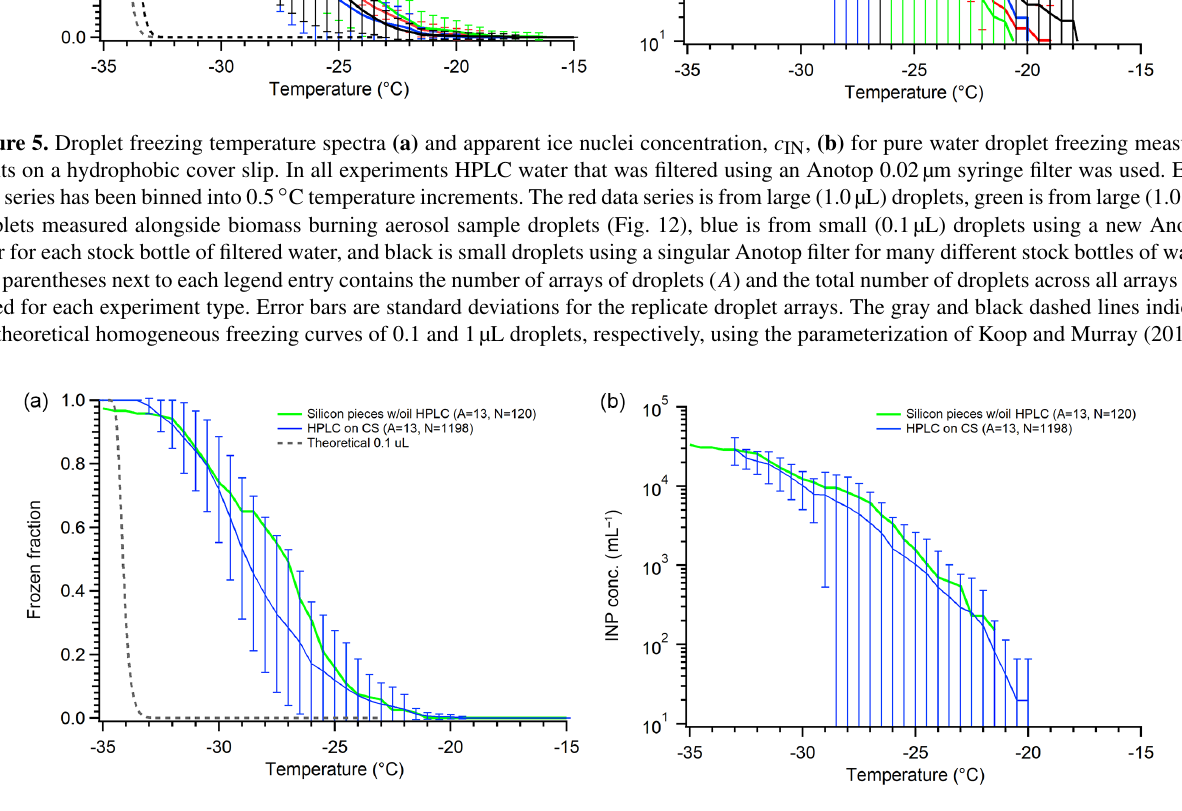
Figure 6. Comparison of freezing on silicon wafer chips (green) against hydrophobic cover slips (blue), following Fig. 5. The freezing temperature spectrum is on (a) , and the retrieved c IN is on (b) . Both datasets use 0.1µL droplets. The data from all replicate arrays using silicon (green) are combined into one series and thus no error bars can be determined. The parentheses next to each legend entry contains the number of arrays of droplets ( A) and the total number of droplets across all arrays ( N ). The gray dashed line indicates the theoretical homogeneous freezing curve of 0.1µL droplets, using the parameterization of Koop and Murray